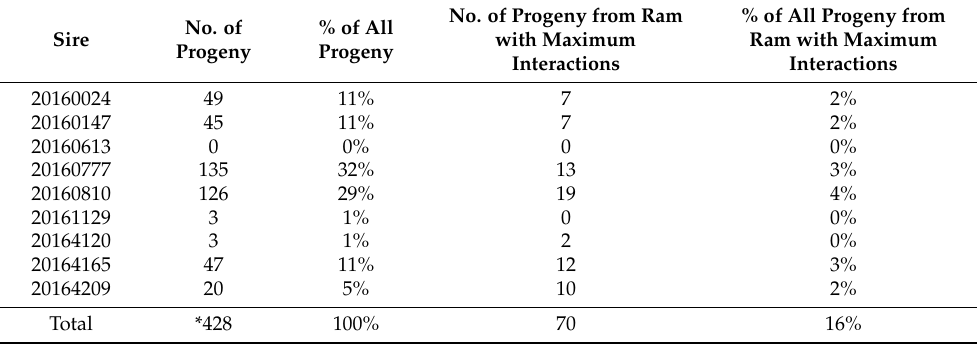
Table 3. The number and percentage of lambs sired by the ram that had the maximum number of interactions with the dam on her estimated day of